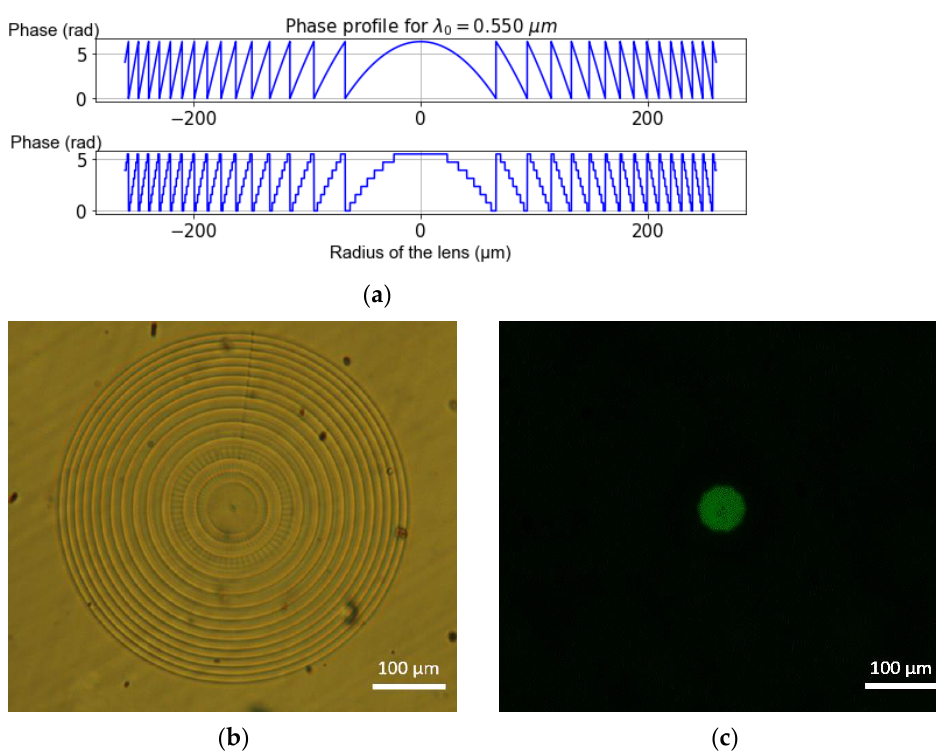
Figure 10. ( a ) The phase profile designed at a central wavelength of 550 nm. ( b ) Microscopic photograph of the graded index Fresnel lens written using the femtosecond laser direct writing technique (x4 objective). ( c ) Image of the field diaphragm of the microscope by the Fresnel lens at the first order (x10 objective, 550 nm filter).